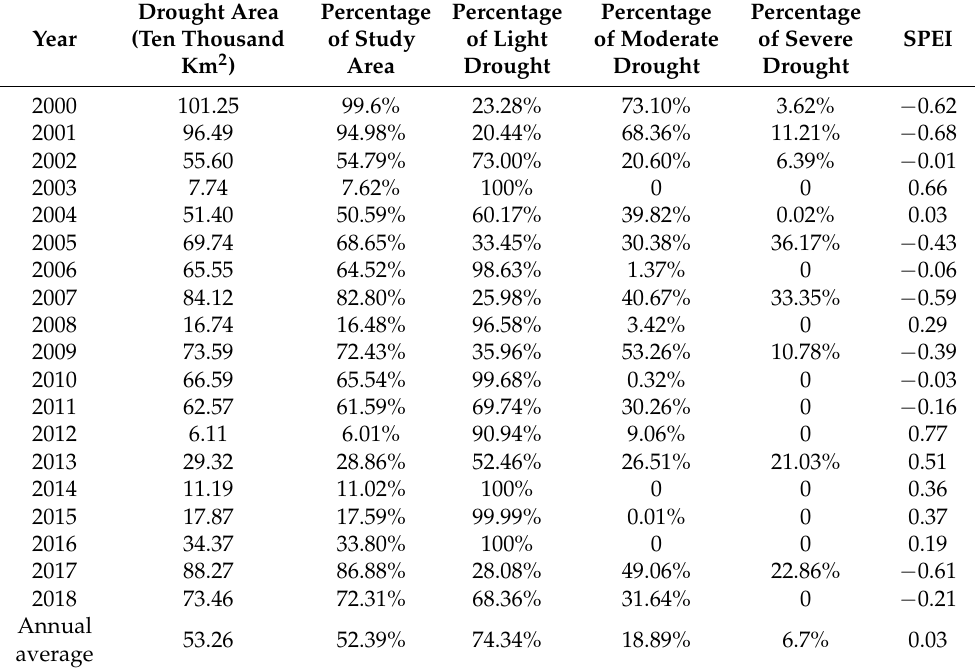
Table 3. Change of drought area and proportion of various types of drought area in the study area from 2000 to 2018.